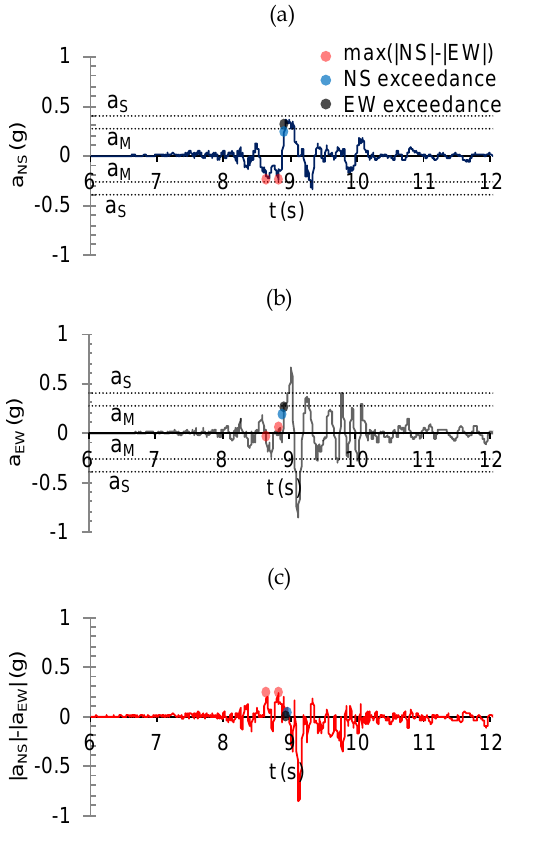
Figure 5. NS (a) and EW (b) acceleration time histo- ries recorded in Amatrice station (AMT) and difference Table 4. Acceleration values corresponding to the in- (c) between the absolute values of the two horizontal stants of the maximum difference between the two hor- components. izontal components and to the attainment of the over- turning threshold in both